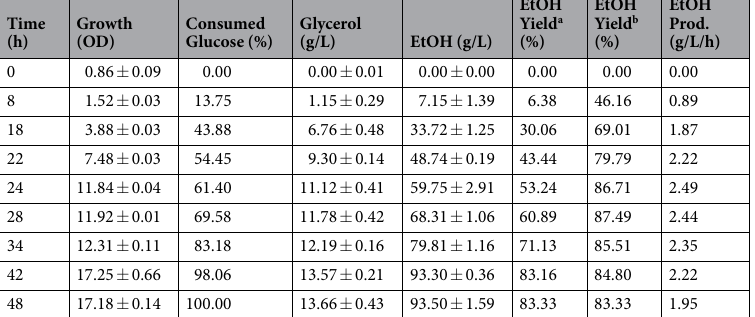
strain in 15 L bioreactors was assessed. SW-YPD (20% glucose) fermentation medium was prepared using natural seawater and inoculated with the marine strain S. cerevisiae AZ65 at a rate of 0.86 ± 0.09 OD. Fermentation was conducted anaerobically at 30 °C and 200 rpm for 48 h. Yeast growth, ethanol concentration, glycerol concentra- tion and the remaining glucose concentration were monitored at regular time intervals, and the results are shown in Fig. 5A and Table 4. Yeast growth reached a maximum OD of 17.25 ± 0.66 after 42 h. All available glucose was utilised by 48 h and there was a concurrent conversion of the glucose into ethanol. The maximum ethanol produc- tion (93.50 ± 1.59 g/L) was recorded at 48 h with 83.33% of the theoretical yield. Ethanol productivity increased